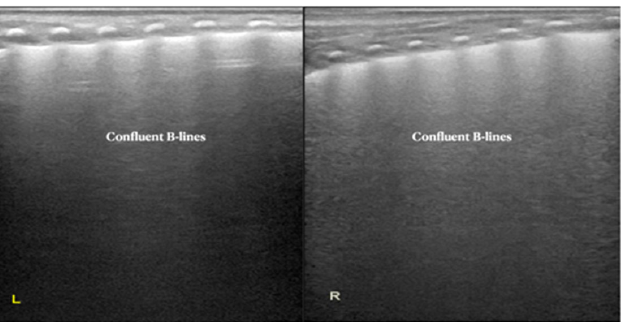
Figure 2. LUS findings of Case 1 infant. LUS presented as confluent B ‐ lines confirmed as TTN (L/R: left/right lung).